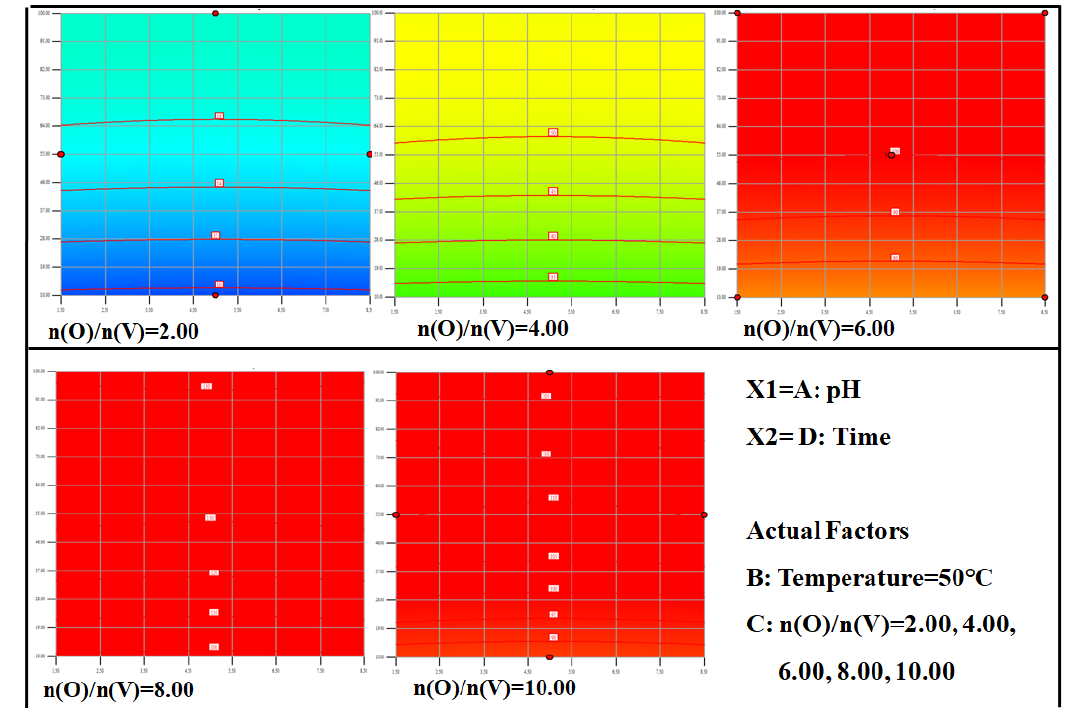
Figure 8. Response surface plots for factors (A to D).